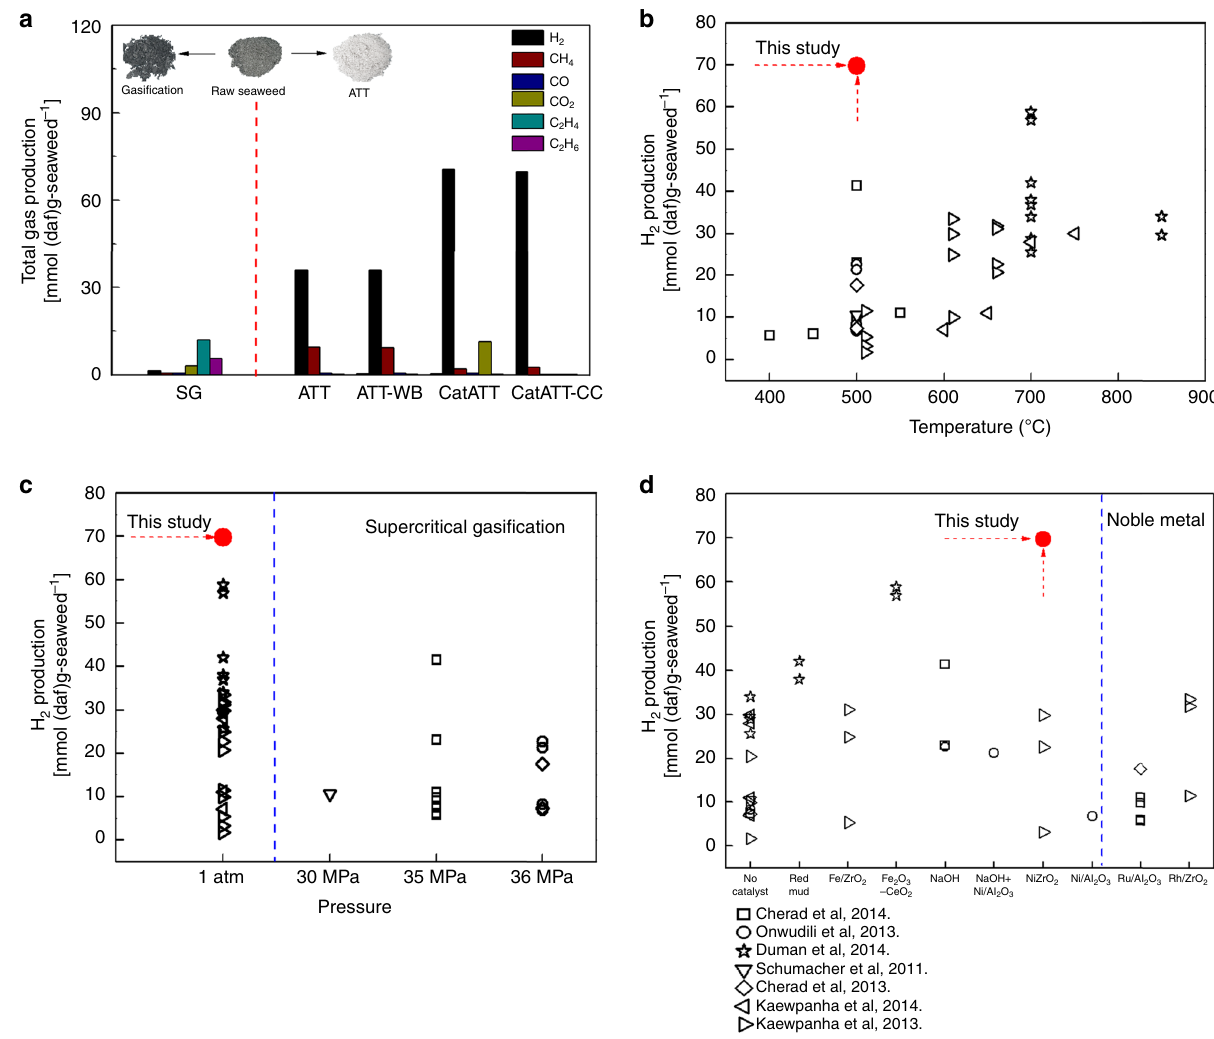
Fig. 2 H 2 production from brown seaweed via ATT and comparisons to previous seaweed gasi fi cation studies. a Major gaseous products generated via SG and ATT reactions performed at 500 °C and 1 atm under a steam atmosphere (temperature program given in the method section). The result is normalized to mmol/(daf)g-seaweed for the direct comparison to the previous seaweed conversion studies. b – d H 2 production via CatATT-CC shown in a is compared to previous studies in terms of b — reaction temperature, c — reaction pressure and d — catalyst Supplementary Table 2. The carbon in procured seaweed is